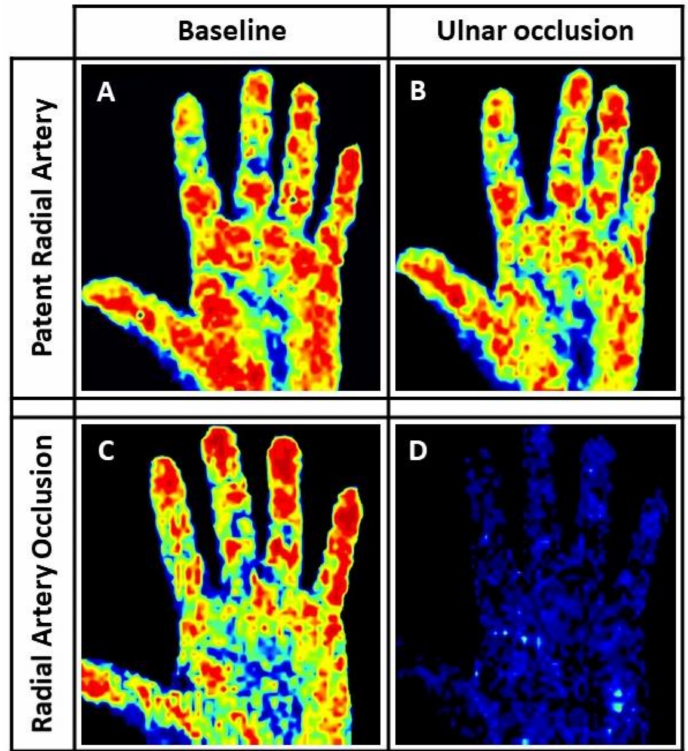
Figure 2. Laser Perfusion Imaging (LPI) of Radial Artery Occlusion (RAO). ( A ) resting left hand LDPI. ( B ) left hand LDPI during complete manual ulnar artery occlusion in a patient with patent radial artery, showing no substantial difference compared to the basal scan (color coded). Accordingly, the RPI was 0.95 in this case. ( C ) resting left hand LDPI. ( D ) left hand LDPI during complete manual ulnar artery occlusion in a patient with RAO, showing ominous reduction of hand perfusion (“blue hand” sign). Consistently with the visual assessment, a dramatic drop of the RPI to 0.17 (82% reduction compared to basal value) was registered in this patient after the trans-radial access (TRA)